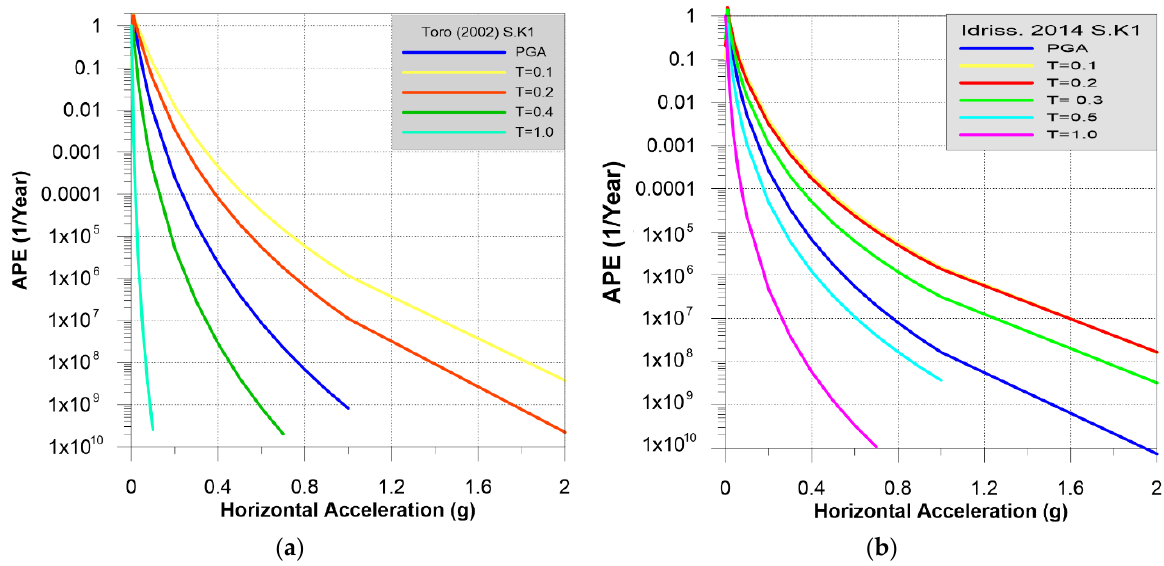
Figure 5. PSHA resultant hazard curves for Site 1 considering ( a ) Toro [29] and ( b ) Idriss [30] GMPEs.